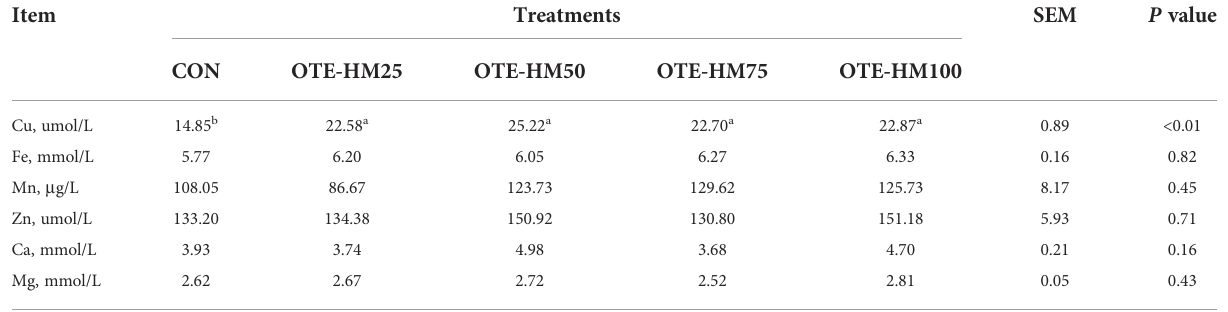
TABLE 4 Effects of experimental diets on trace element concentration in blood of laying ducks 1 .